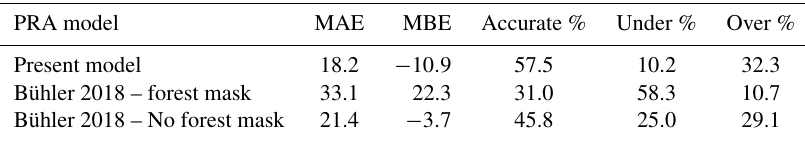
Table 3. PRA model